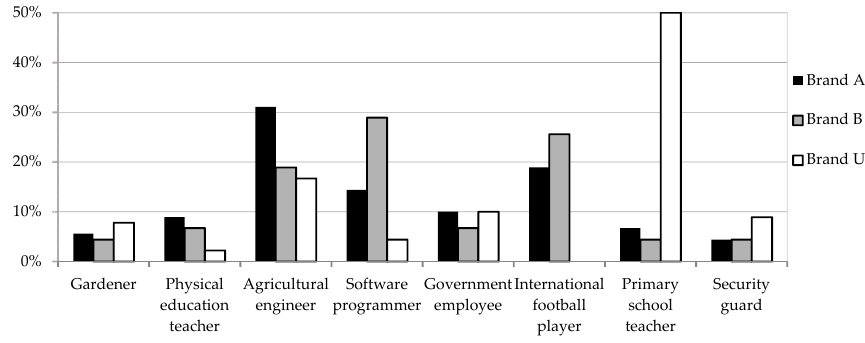
Figure 1. Frequency of mention of each JPO according to brand: Uruguay.